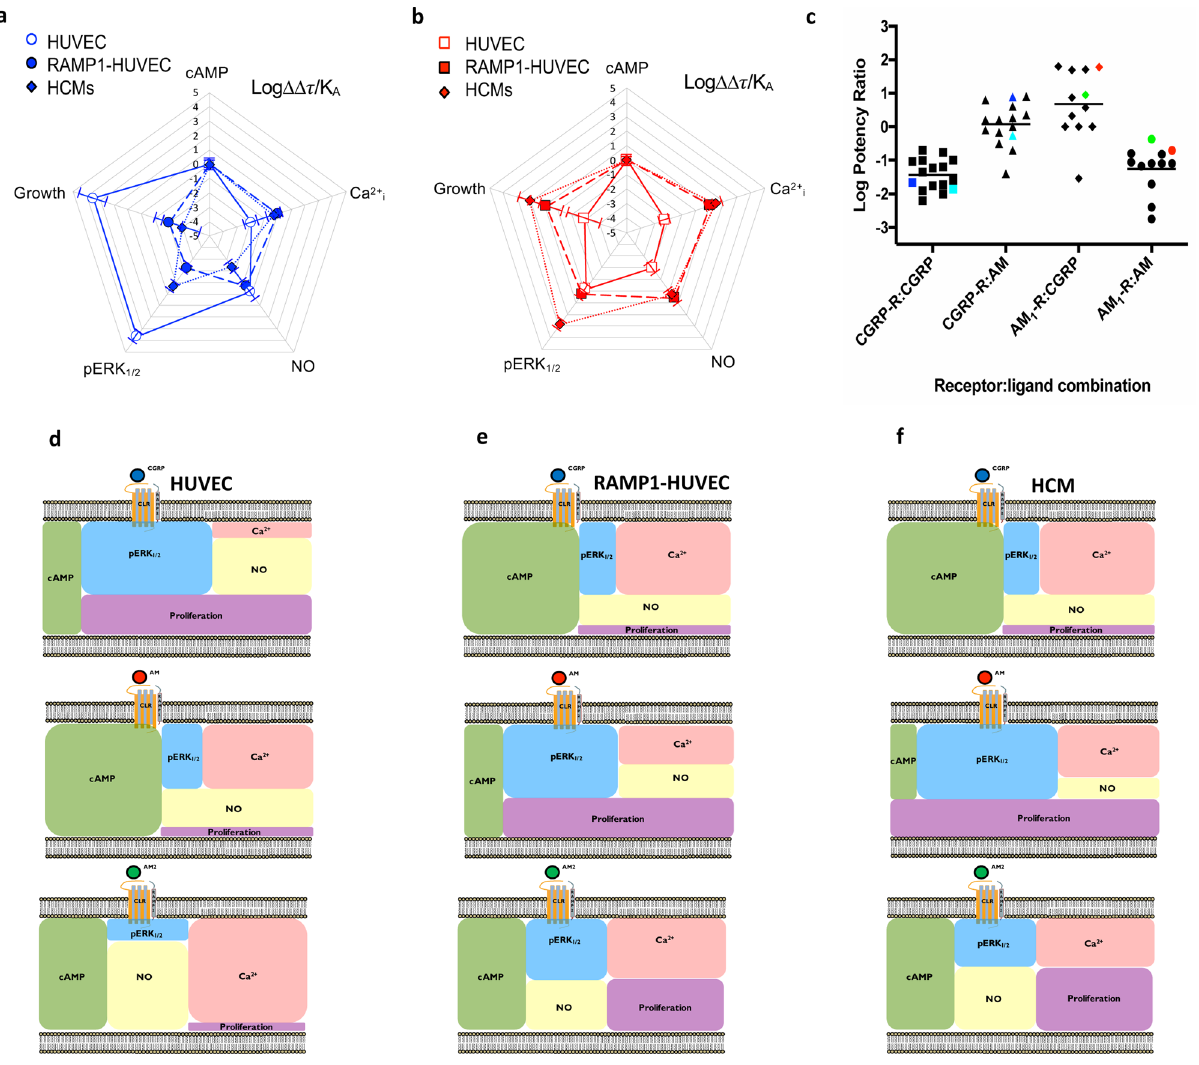
Fig. 5 CGRP signalling bias in RAMP1 expressing HUVECs correlates with that in HCMs. a Signalling bias plots were calculated as ΔΔ Log( τ /K A ) for CGRP in the three cell lines, HUVECs, RAMP1 expressing HUVECs and HCMs for each pathway. Values have been normalised to a reference agonist (AM2) and the reference pathway (cAMP) for all three cell lines. b As for ( a ) except the calculated values are for AM. c Log potency ratios (as measured by the accumulation of cAMP) calculated as Log (EC 50 AM2/EC 50 agonist). Data are compiled from 12,19 . HUVECs and HUAECs are shown in red and green respectively, HCMs in cyan and RAMP1-HUVECs in blue. d – f Schematic representation of the signalling bias produced by CGPR ( d ), AM ( e ) and AM2 ( f ), and the intracellular ‘ signalling codes ’ they bring about based on the potencies recorded at individual pathways in HUVECs, RAMP1-HUVECs, and